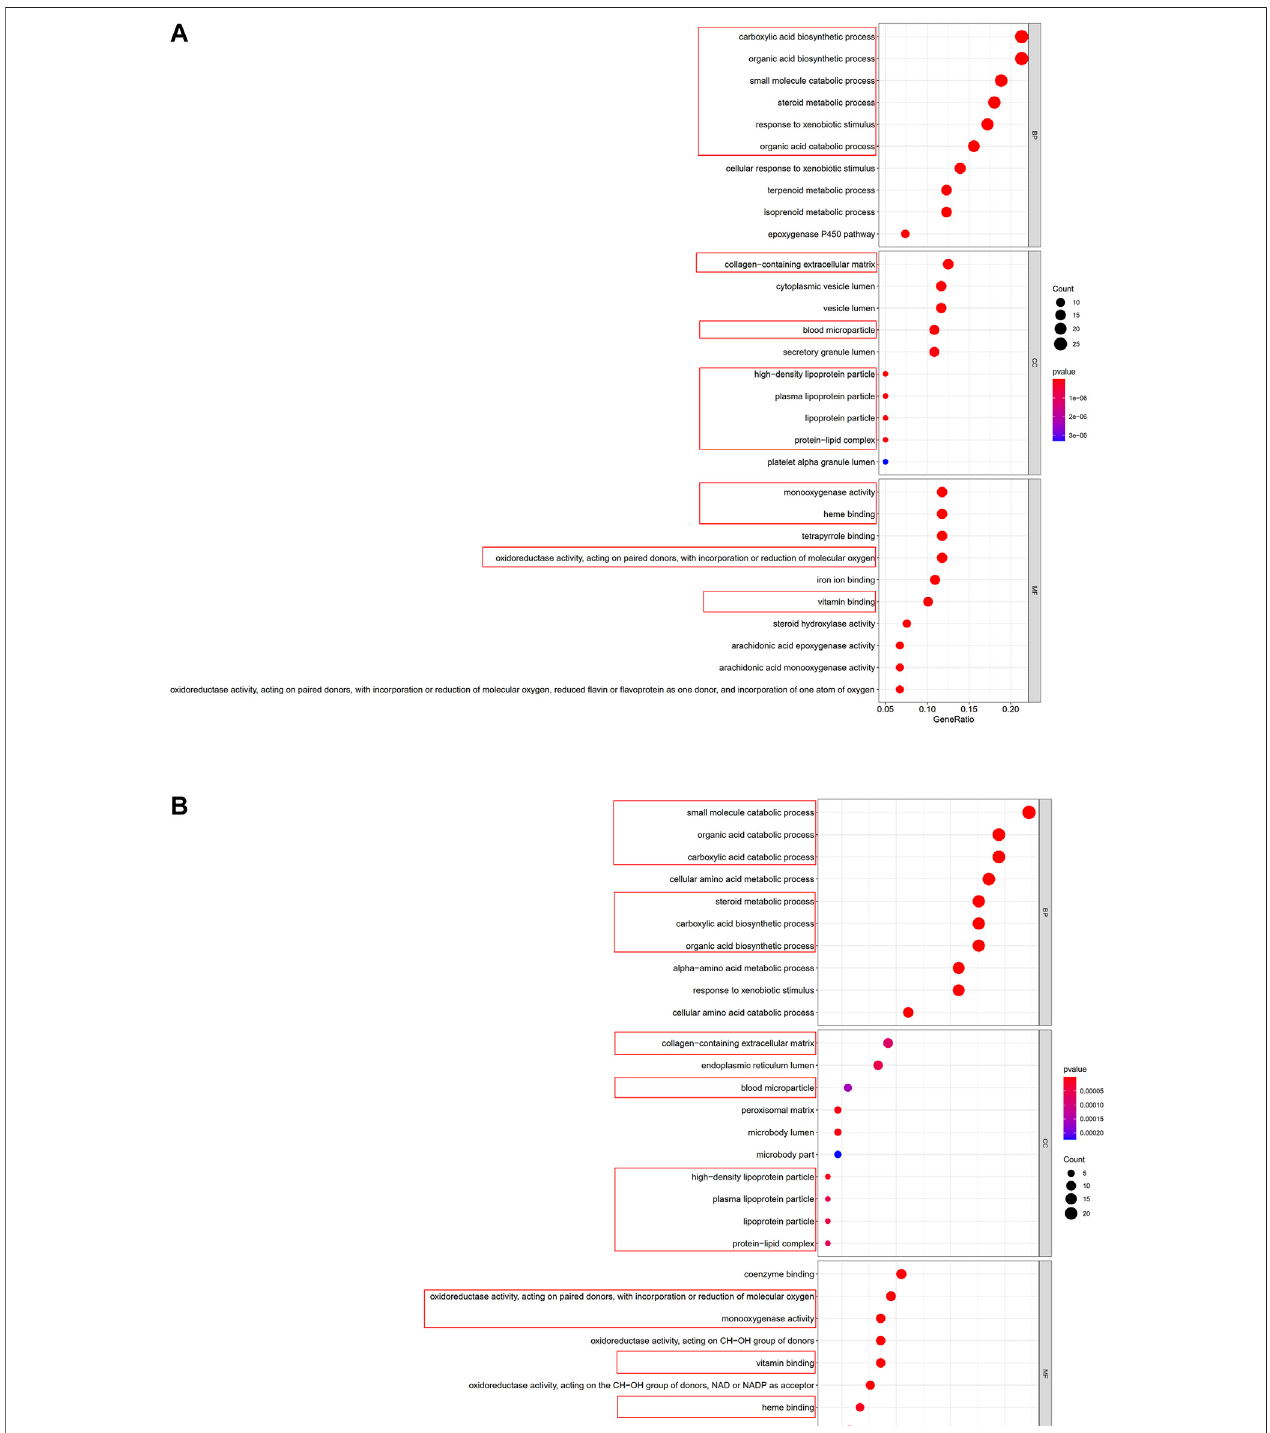
FIGURE 9 | Representative results of GO analyses. (A) GO enrichment in the TCGA cohort. (B) GO enrichment in the GSE14520 cohort.